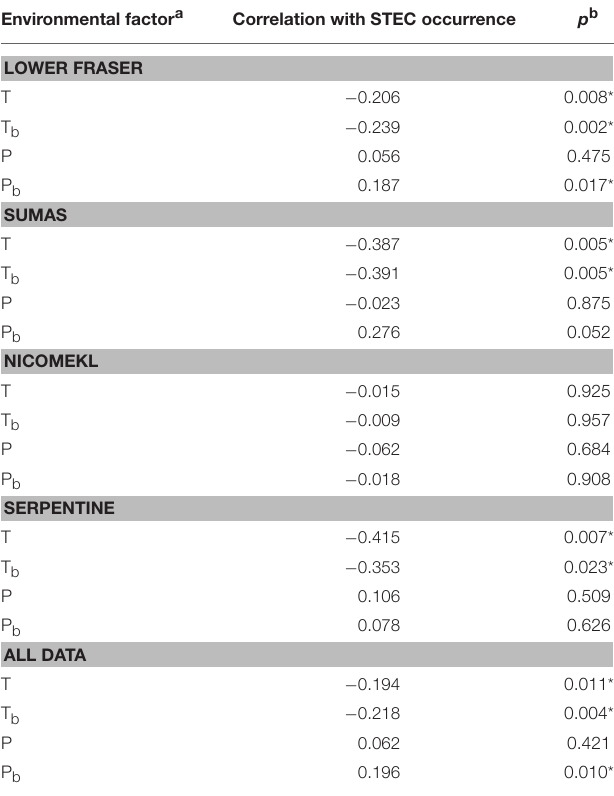
TABLE 4 | Virulence gene profiles determined by PCR and conventional serological assignments of STEC recovered from surface waters and sediments in the Lower Mainland of British Columbia ( n =